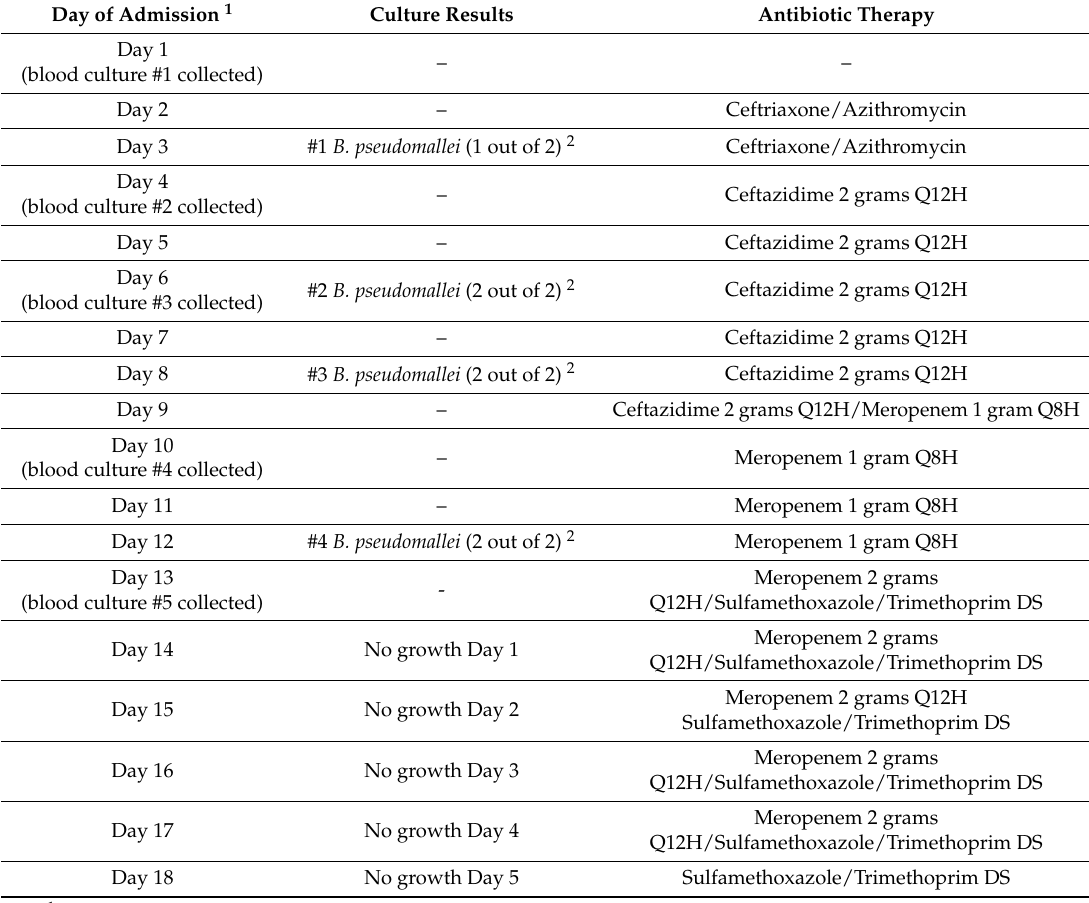
Table A1. Antibiotic therapy and culture results throughout